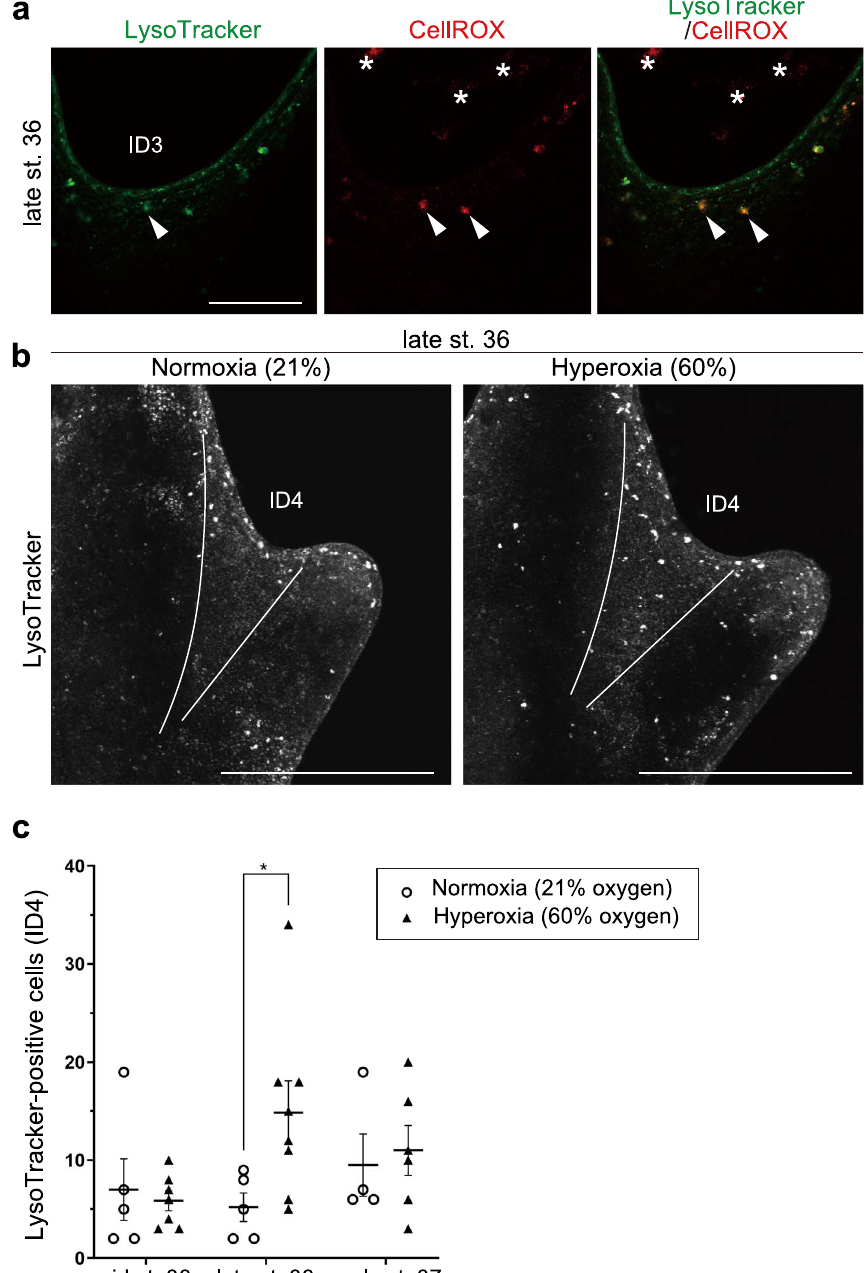
Fig. 2 Distribution of cell death and ROS during limb development and experimental conditions in R. pirica . a Cell death (LysoTracker Green) and ROS (CellROX) staining of late stage 36 R. pirica hindlimbs. The arrowheads point to cells positive for both LysoTracker and CellROX staining. The asterisks are microbes, not stained cells. b Cell death (LysoTracker Red) in late stage 36 R. pirica hindlimbs incubated for 3 hours under normoxia or hyperoxia. c Quantification of LysoTracker–positive cells in ID4 of the hindlimbs indicated in ( b ). Each symbol represents an individual specimen. Mean SEM. Two–tailed unpaired t –test. p < 0.05. ID3–4: interdigital regions 3 and 4. Scale bar, 100 μm in ( a ) and 500 μm in ( b ± ∗